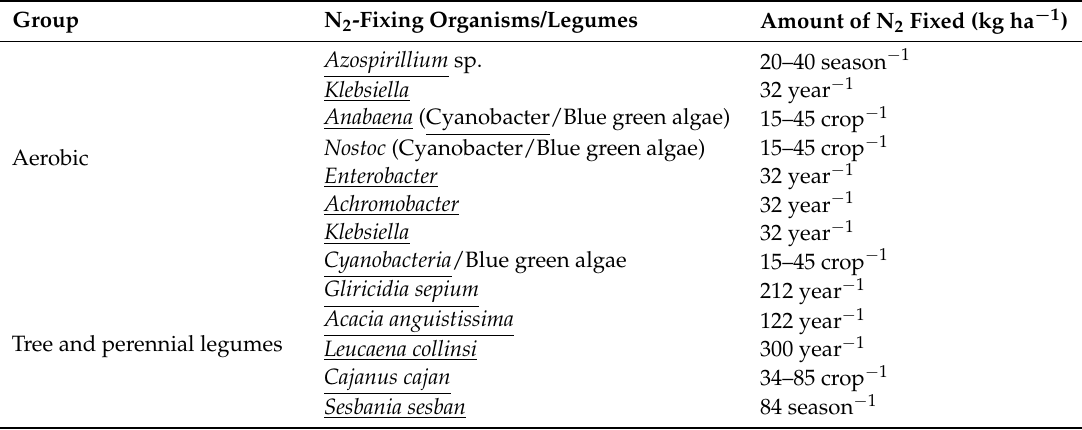
Table 4. Amount of N 2 fixed (kg ha − 1 ) by some common aerobic and anaerobic N 2 -fixing organisms and tree legumes (adapted from Akinnifesi et al., 2010, Canadian Center of Science and Education,